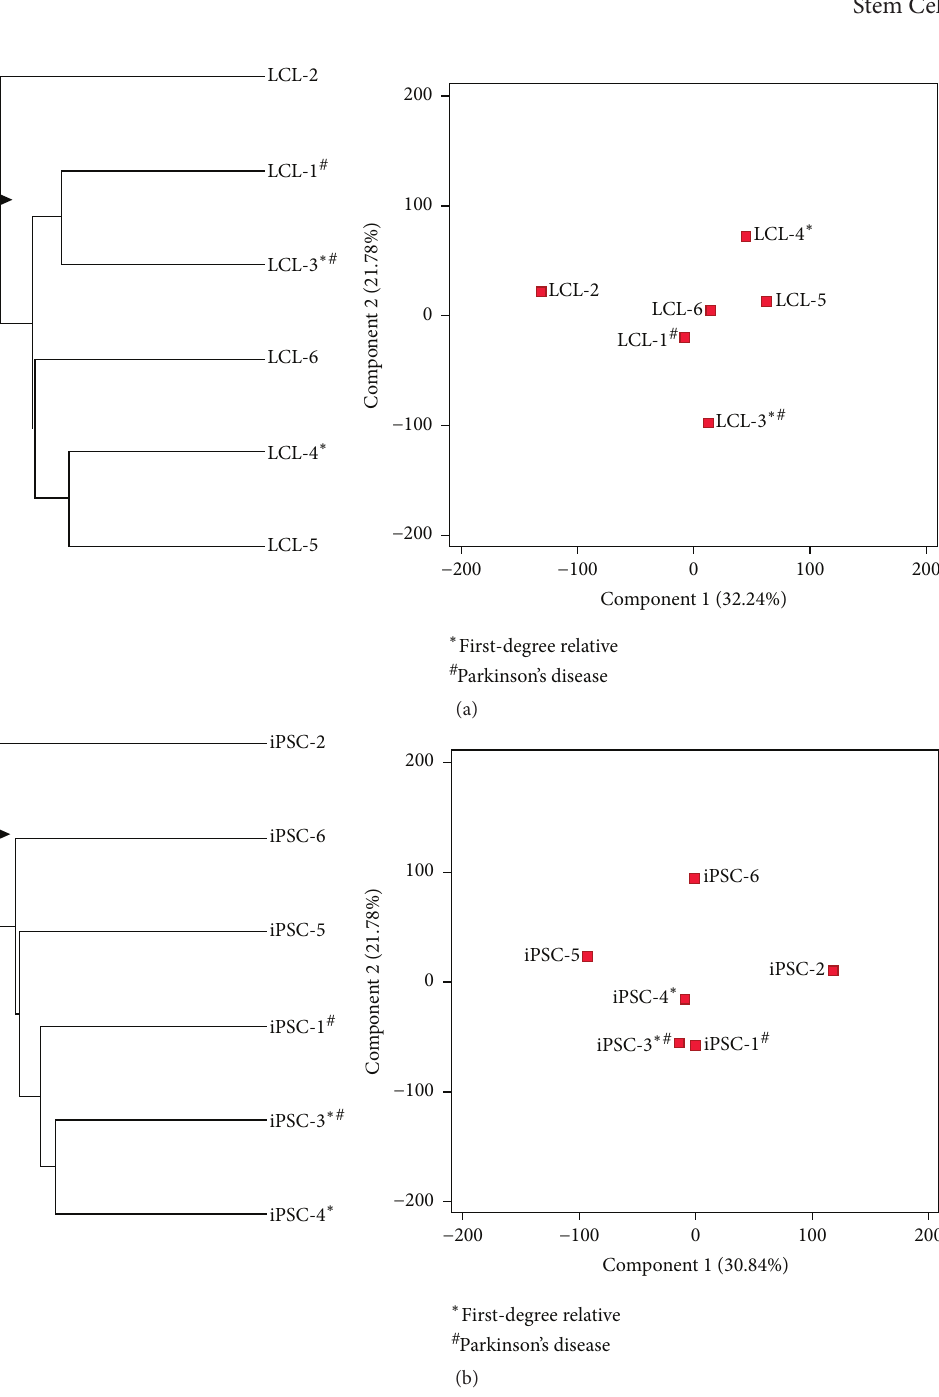
Figure 8: Clustering properties of LCLs and their reprogrammed iPSCs (a) Hierarchical clustering analysis and PCA in LCLs based on all genesdetectedasexpressedduringLCL-to-iPSCreprogramming.(b)HierarchicalclusteringanalysisandPCAingeneratediPSCsbasedonall genes detected as expressed during LCL-to-iPSC reprogramming. # The donors of LCL-1 and LCL-3 were diagnosed with sporadic Parkinson’s disease. The donors of LCL-2, LCL-4, LCL-5, and LCL-6 were healthy. ∗ The donors of LCL-3 and LCL-4 were first-degree relatives whereas all other donors were